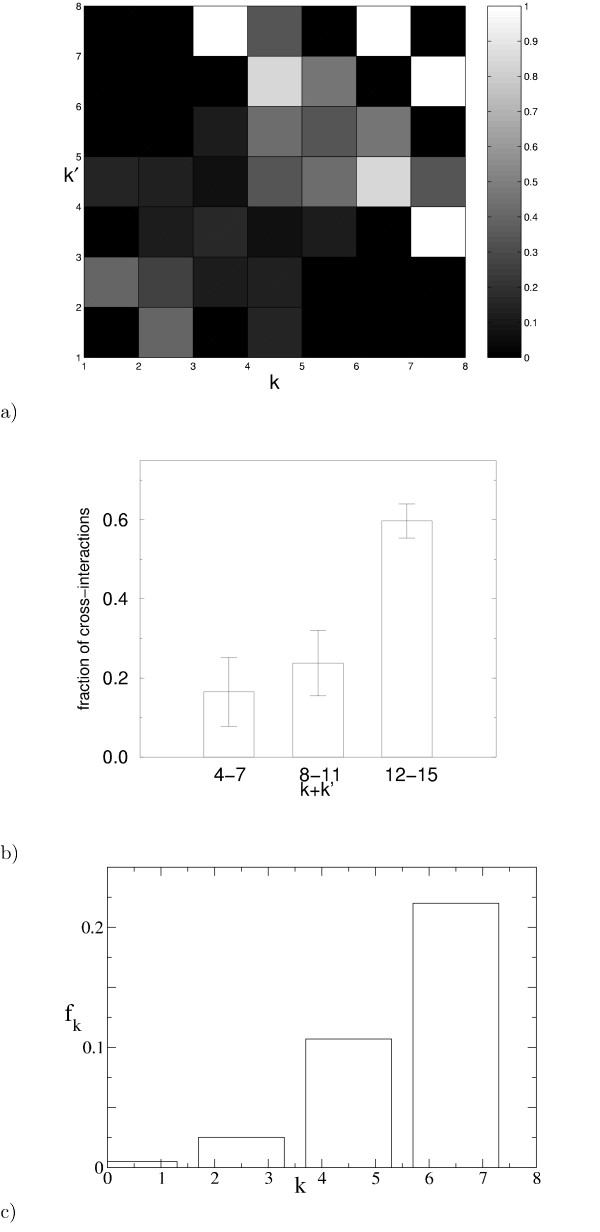
Link attachment occurs preferentially towards proteins of high connectivity. (a) The color-coded plot shows the fraction of duplicate pairs with connectivities (k, k') that have gained a mutual interaction (cross-interaction) since duplication, as a function of k and k'. Points where all duplicate pairs have cross-interactions are shown in white, points where none carry a cross-interactions are shown black. Points (particularly at high connectivities) where no data is available are also shown in black. The number of duplicate pairs with given connectivities ranges from 2 to 39. Points in the k, k'-plane where only a single pair of duplicates exists are excluded. (b) For this histogram the data from a) are binned for low, medium, and high k + k' and the average for each bin is shown against k + k'. The number of k, k' values contributing to each bin are 10, 14, and 11, from left to right. Error bars give the standard error. (c) Assuming the functional form fk + fk' for the probability of a cross-interaction between nodes with connectivities k and k' (asymmetric attachment), the most likely values of fk may be deduced from the data (see text). The maximum-likelihood result shows an approximately linear increase of fk with k. The alternative scenario, symmetric attachment, yields a smaller maximum likelihood. Only duplicate pairs with Ka ≤ 0.4 were used in this analysis in order to avoid overcounting of cross-interactions of duplicates of even older duplicates.